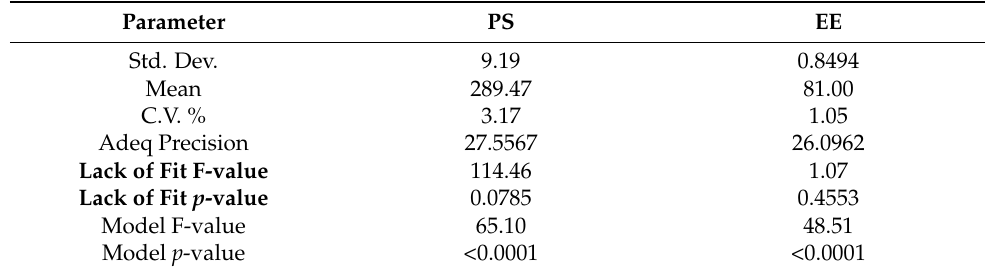
Table 3. Model (quadratic) fit summary of the responses.